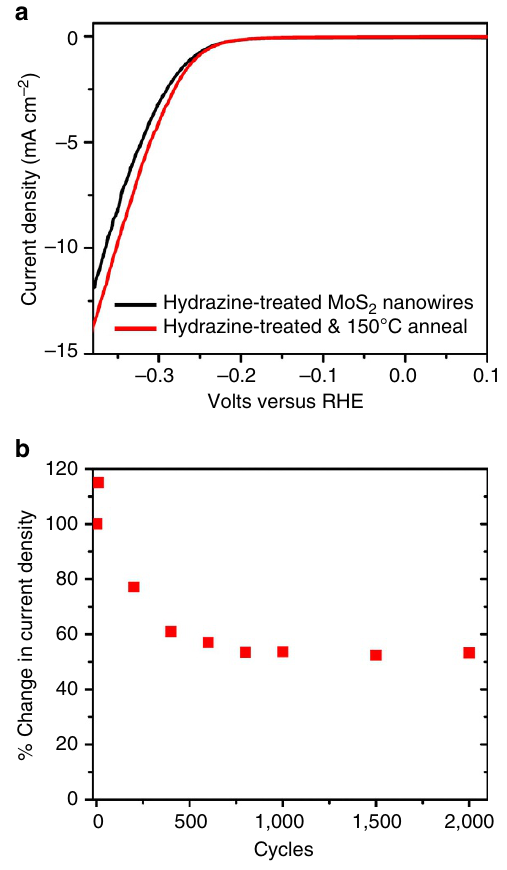
Figure 6 | Stability studies of hydrazine-treated MoO x /MoS 2 core-shell nanowire. ( a ) Linear voltammetry for MoO x /MoS 2 core-shell nanowires treated with Hydrazine (red curve), then annealed at 150 (cid:2) C for 1h (red dashed line). ( b ) Stability of hydrazine-treated MoO x /MoS 2 core-shell nanowires over 2,000 cycles. Current densities are normalized to B 24mAcm (cid:2) 2 as